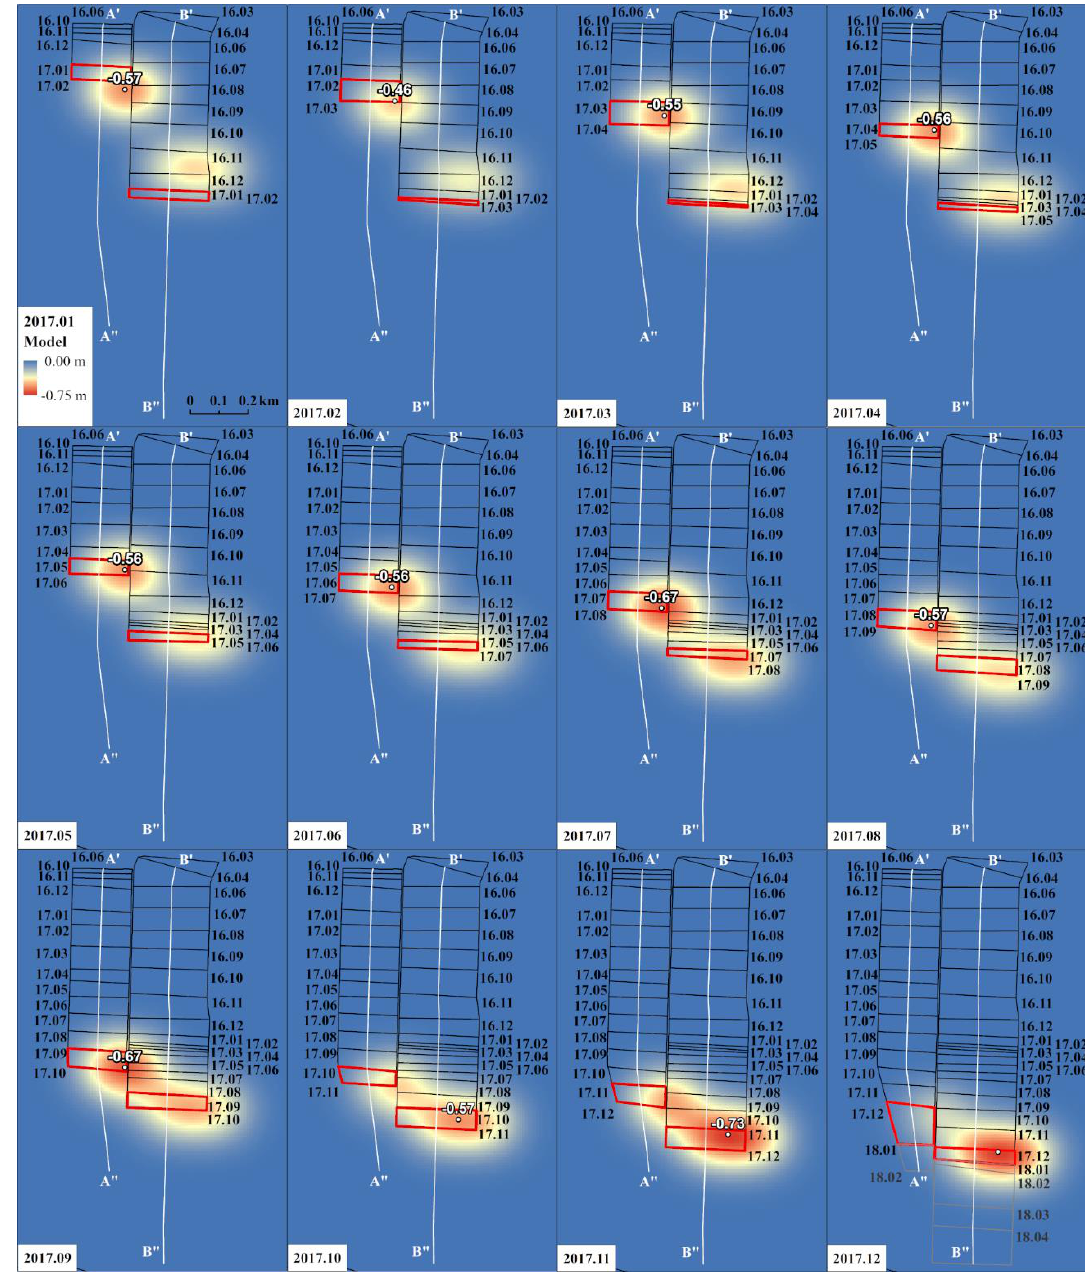
Figure 13. Monthly advancement of coal extraction presented by the red panels and the main subsidence presented by images according to the prediction models based on the Knothe–Budryk theory. Profiles along the line A’A” are shown in Figure 15 and along the line B’B” in Figure 17.